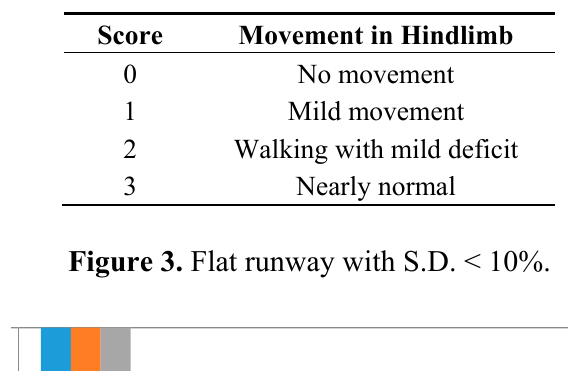
Table 3. Evaluation of behavior of rats on different runways.